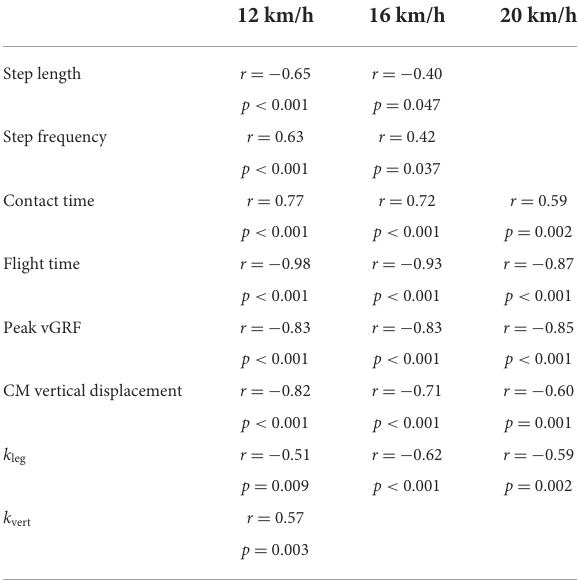
TABLE 1 Significant correlations ( p < 0.05) between duty factor and key variables for all 25 players at each of the three treadmill running